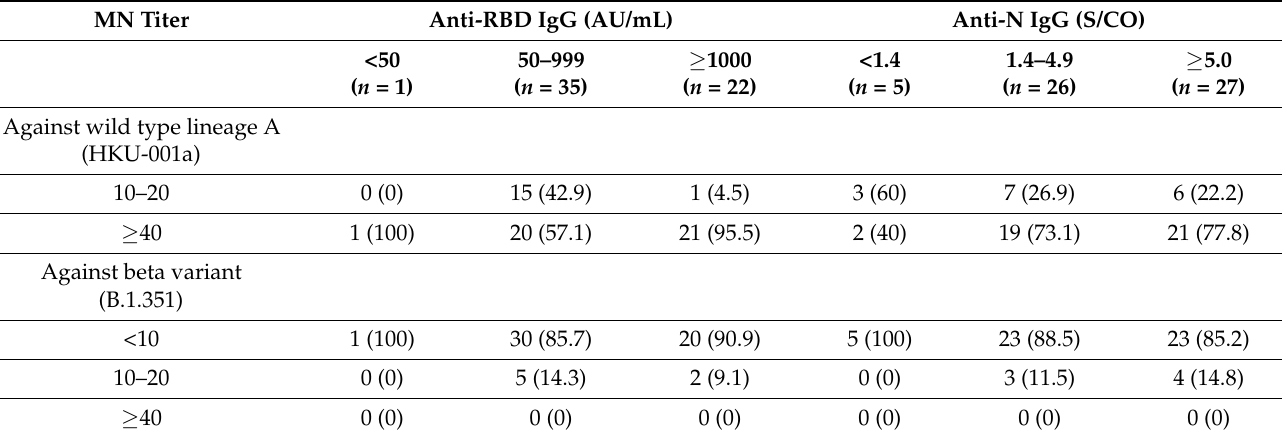
Table 1. Correlation between binding antibody titer and microneutralization antibody